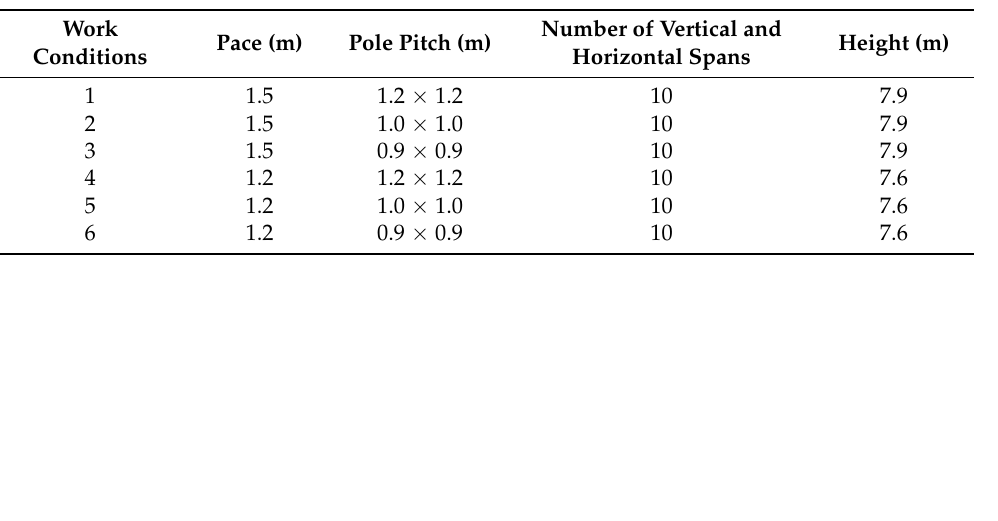
Table 10. Parameters of template support